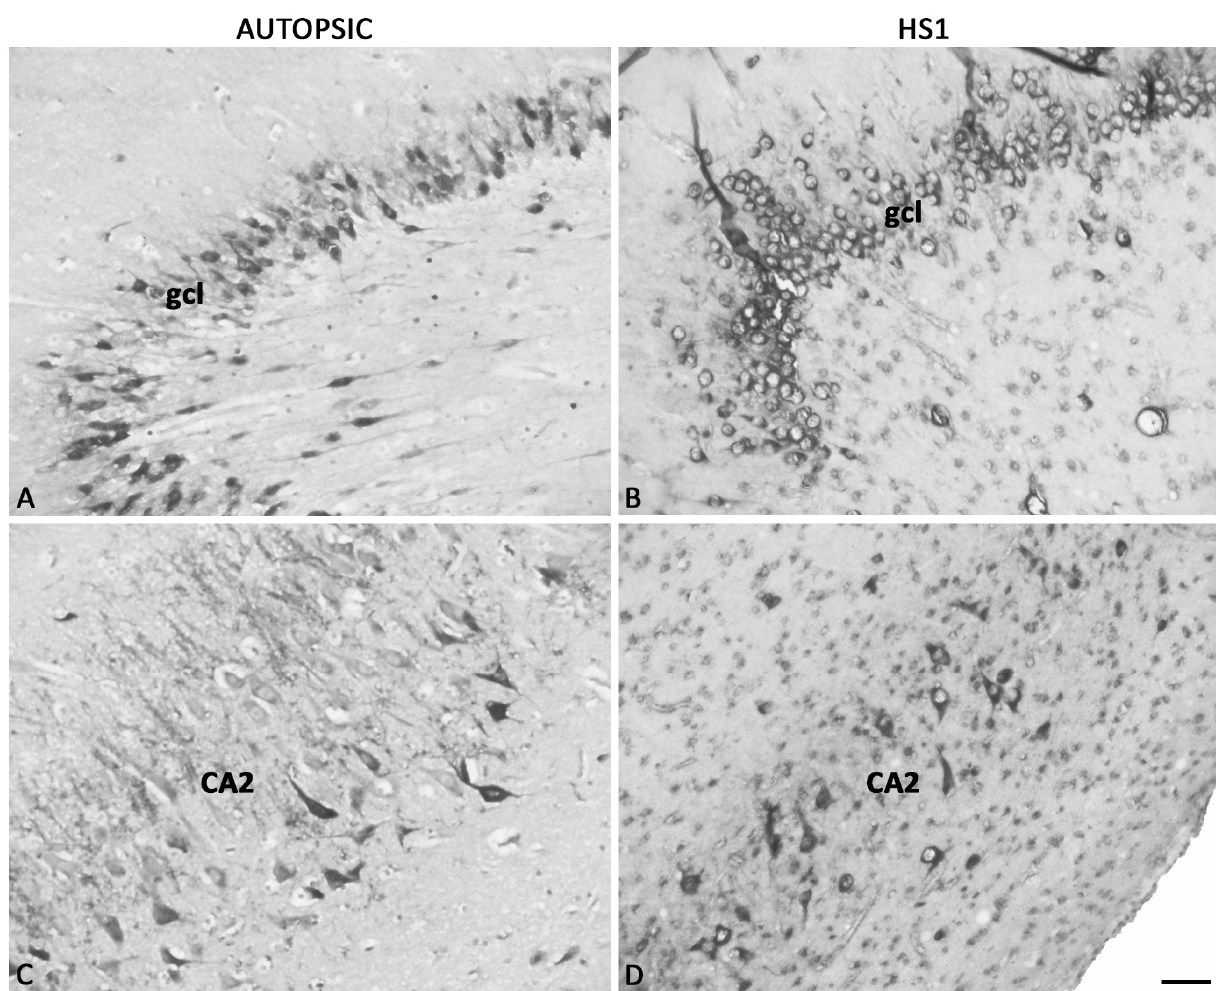
Figure 4. Immunohistochemically stained aggrecan (AGG) in sections of mature hippocampi